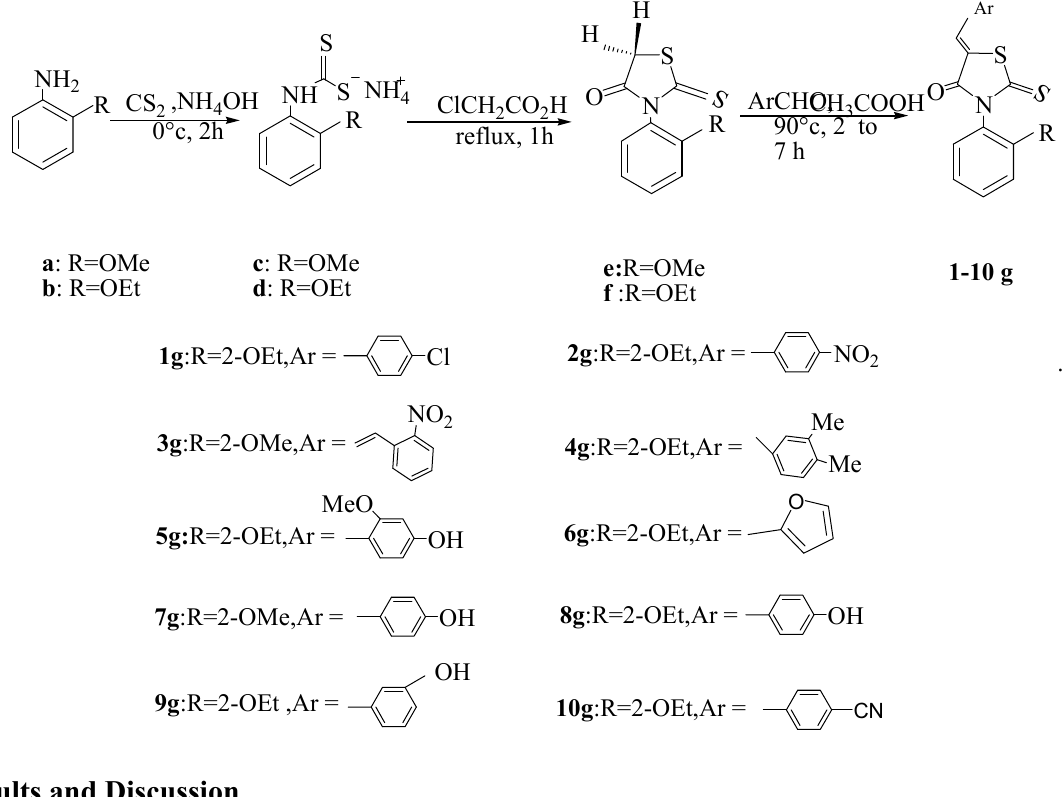
Scheme 1. Synthesis of